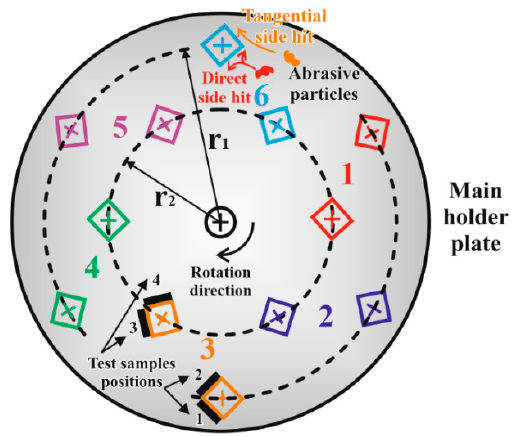
Figure 2. Assembly of the slurry containing test system. ( a ) Structure; ( b ) In operation.